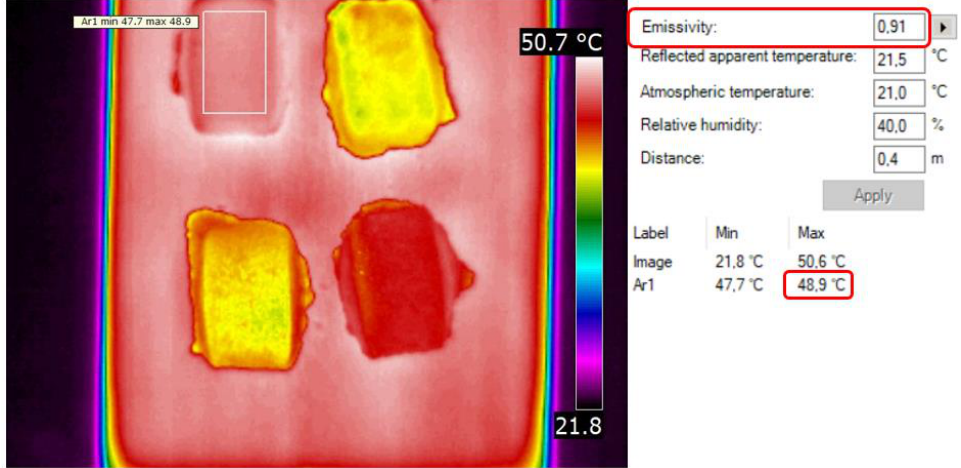
Figure 9. Exemplary determination of briquette emissivity from M1 mixture in FLIR QuickReport 1.2. Table 1. Emissivity of briquettes from individual materials at 49 °C (±0.1 °C). Temp. Maximum for